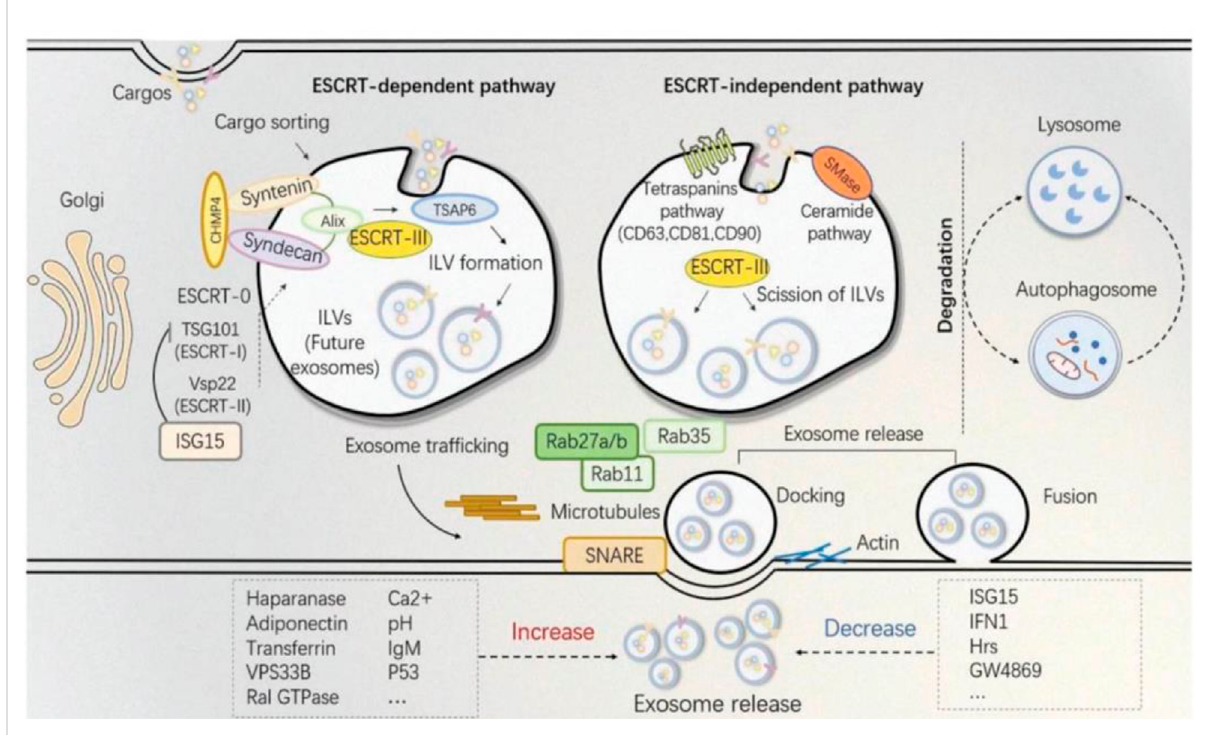
FIGURE 2 The established theory of exosomes biogenesis indicates different pathways distinguished as ESCRT-dependent and ESCRT-independent (Shi et al., 2021).